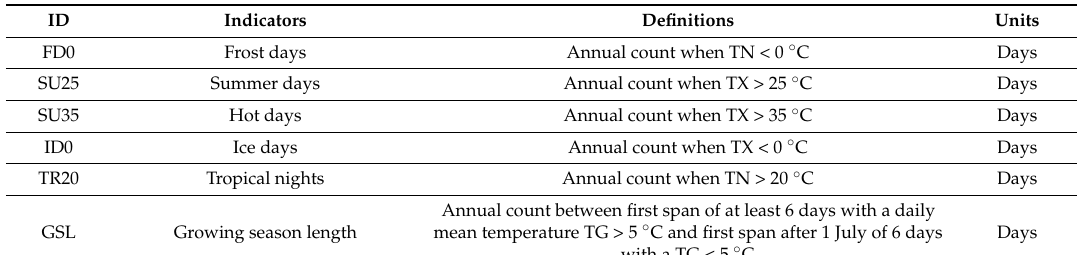
Table 2. The definitions of the 21 climate indices used in this